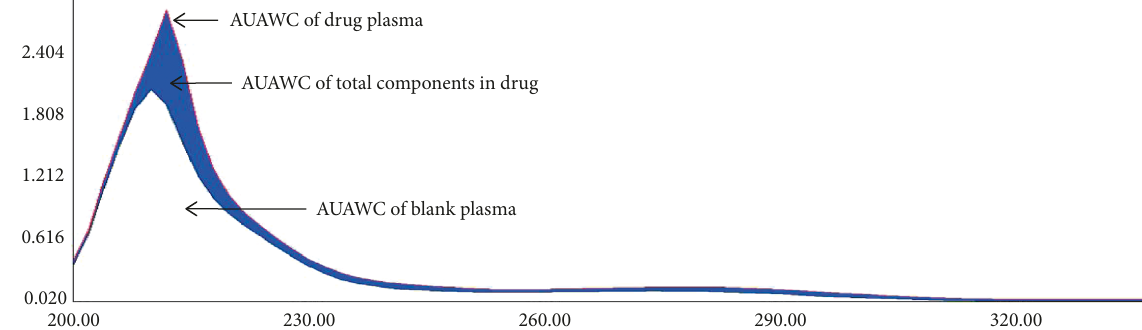
Figure 1: AUAWC of blank plasma and drug plasma sample. (1) AUAWC of drug plasma: a full spectrum scanning for the plasma sample from the rat with the administered drug. (2) AUAWC of blank plasma: a full spectrum scanning for the plasma sample from the rat without